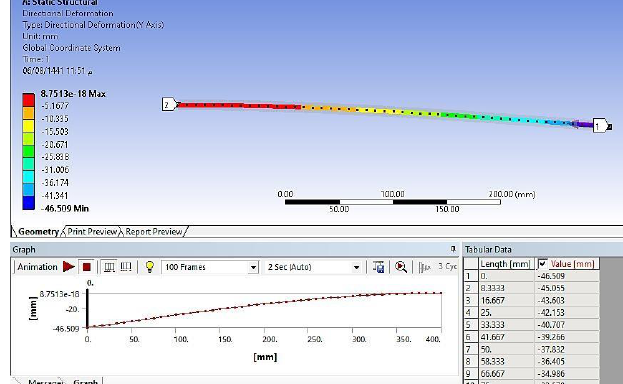
Fig. 5. Fixed-fixed beam with a centre load